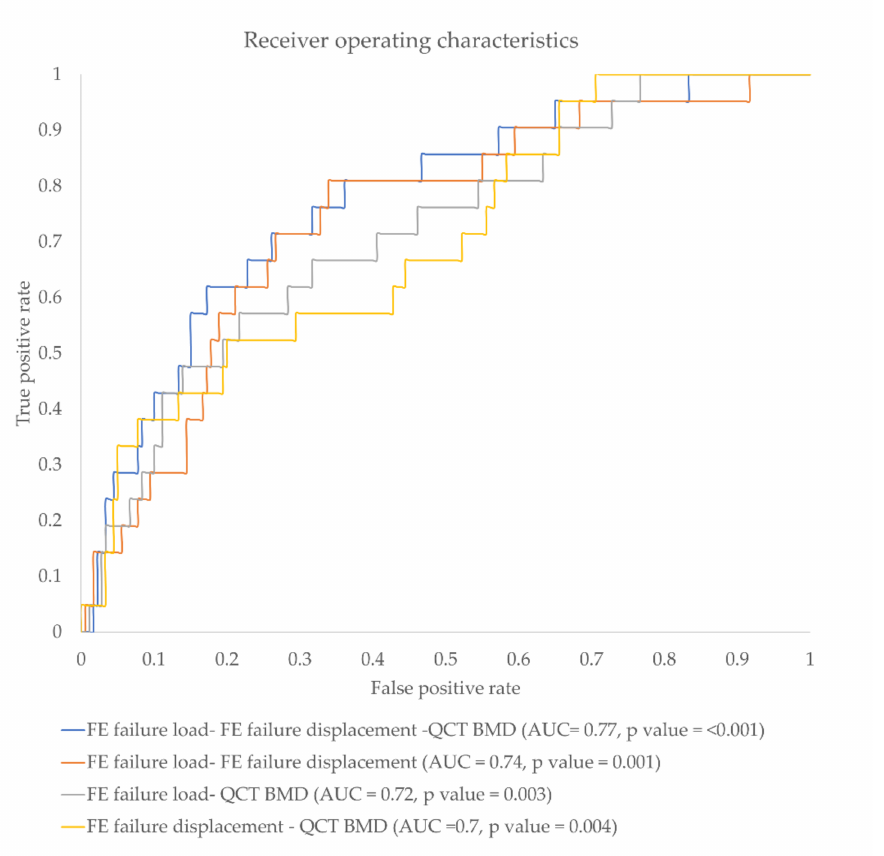
Figure 5. Receiver operating characteristics (ROC) curve showing false-positive rate vs. true-positive rate for different parameter